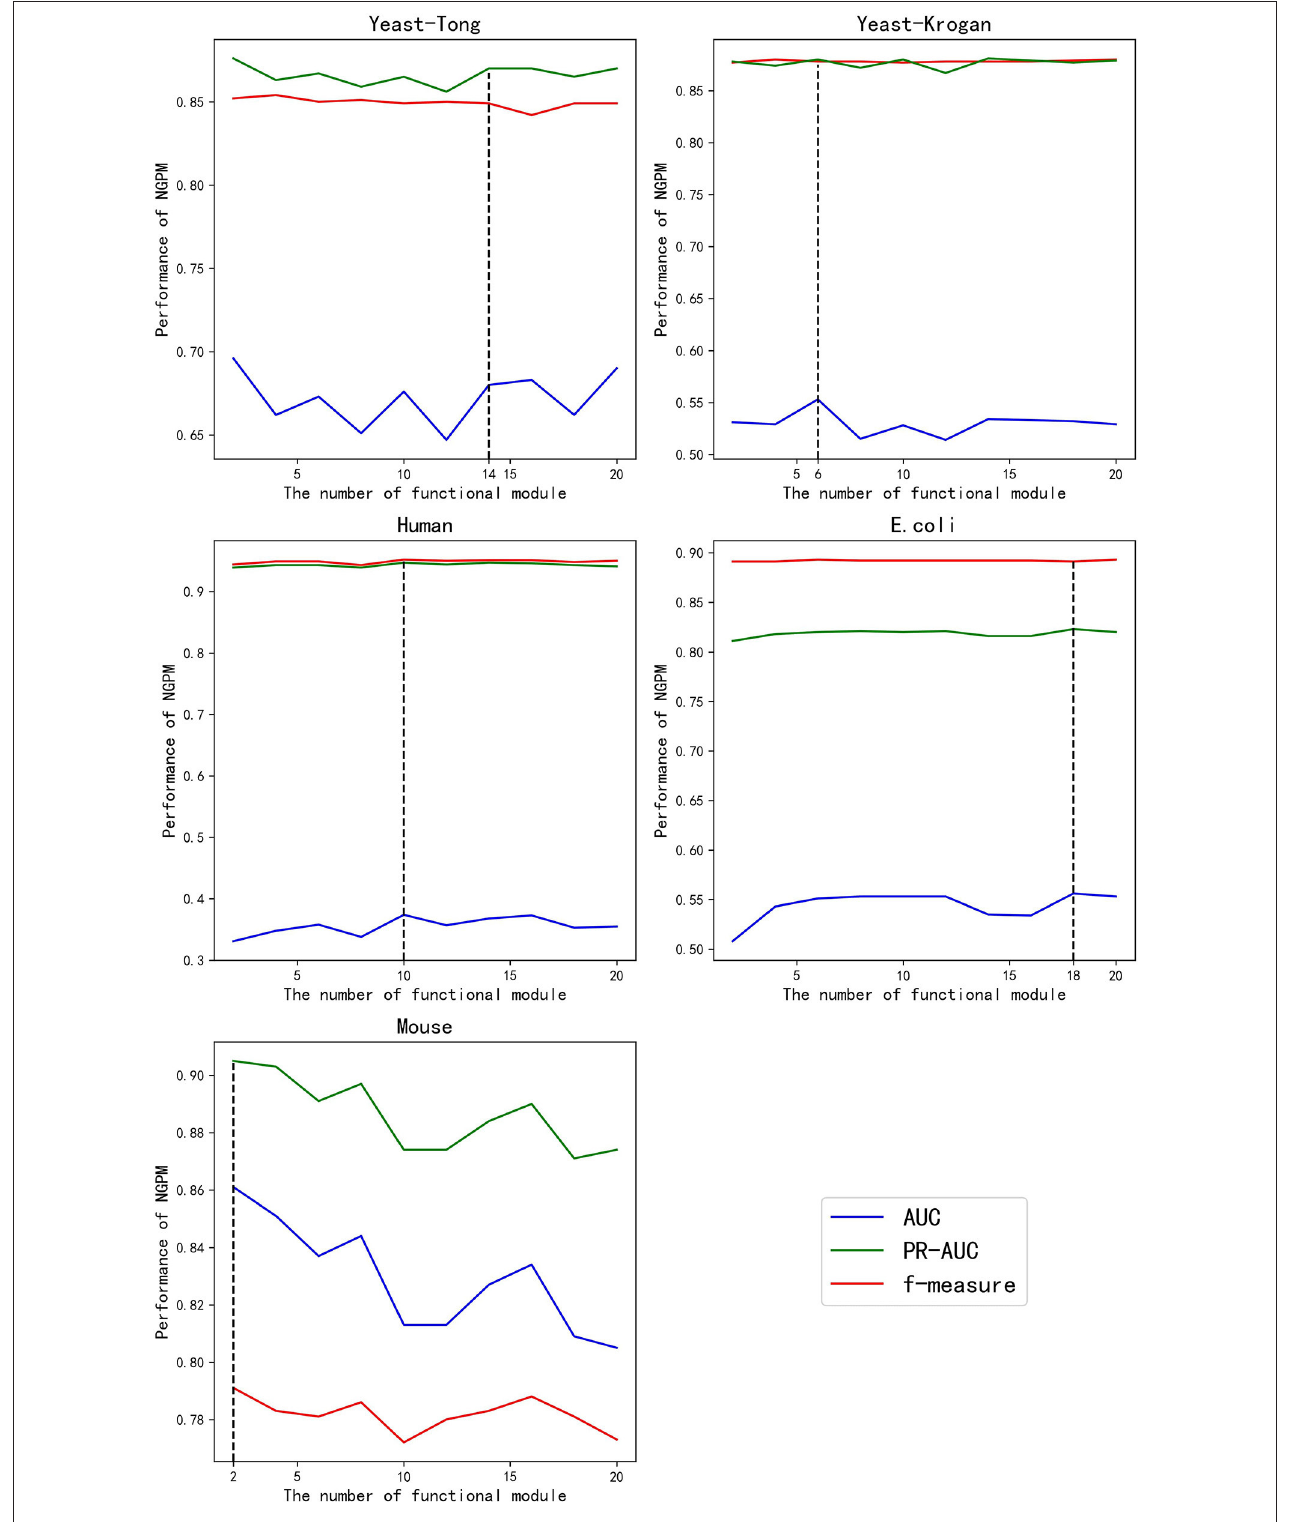
FIGURE 3 | The performance of NGPM given different values of K